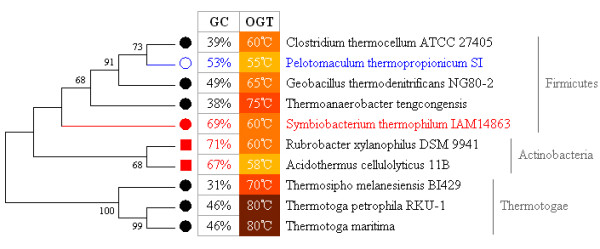
Contribution of alpha-dimer asymmetry and optimal growth temperature (OGT) to GC content variation. This dataset contains 10 thermophilic bacteria of three different phyla (five from Firmicutes, two from Actinobacteria, and three from Thermotogae), which have a broad GC content (from 31% to 71%) and OGT (from 55°C to 80°C) variation. The solid circles denote bacteria of the dnaE3|polV group, with two exceptions (one, labeled in blue, which lost polC, and the other, labeled in red, has an insertion of dnaE2). The red squares denote bacteria of the dnaE1|dnaE2 group. The phylogenetic tree was constructed using the NJ method of MEGA 4.0 by using 16s rRNA sequences. Bootstrap values (>50) are labeled.